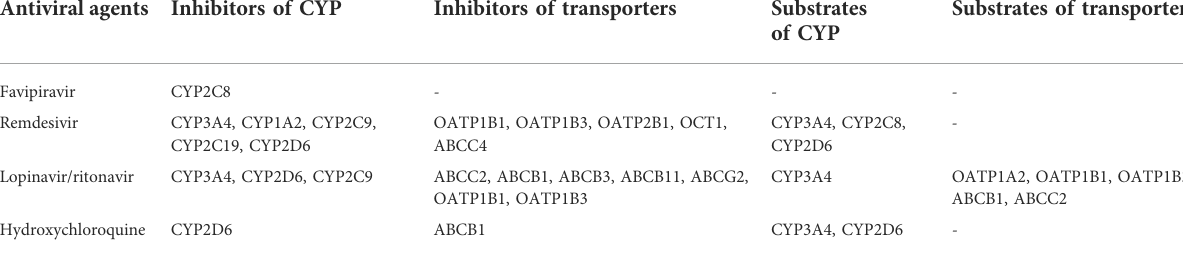
TABLE 2 Relationship between antiviral agents and CYP or transporters. Antiviral agents Inhibitors of